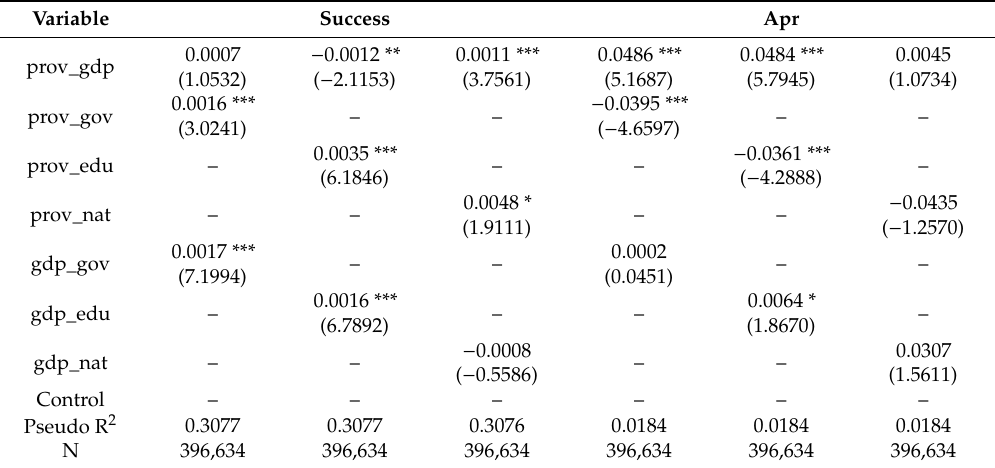
Table 11. Interactive e ff ects of potential causes of geographic